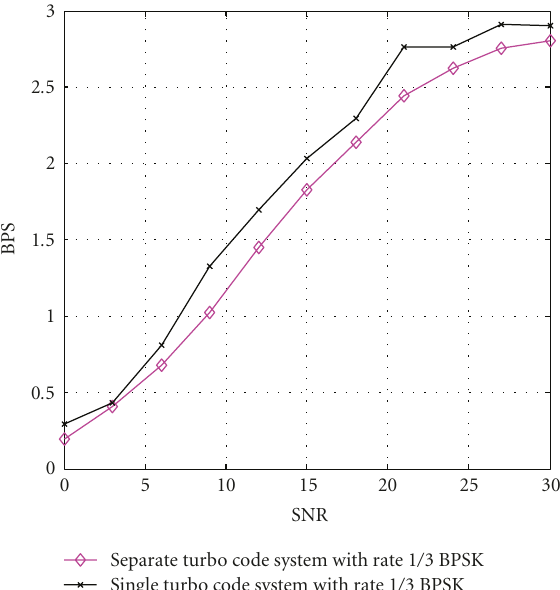
Figure 11: Throughput of separate turbo code system and one turbo code system with rate 1/3